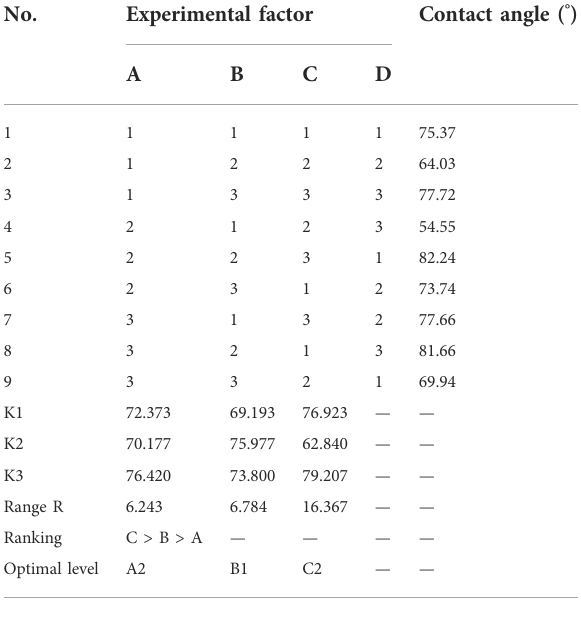
TABLE 3 Optimization of the results of the orthogonal experimental design. No.